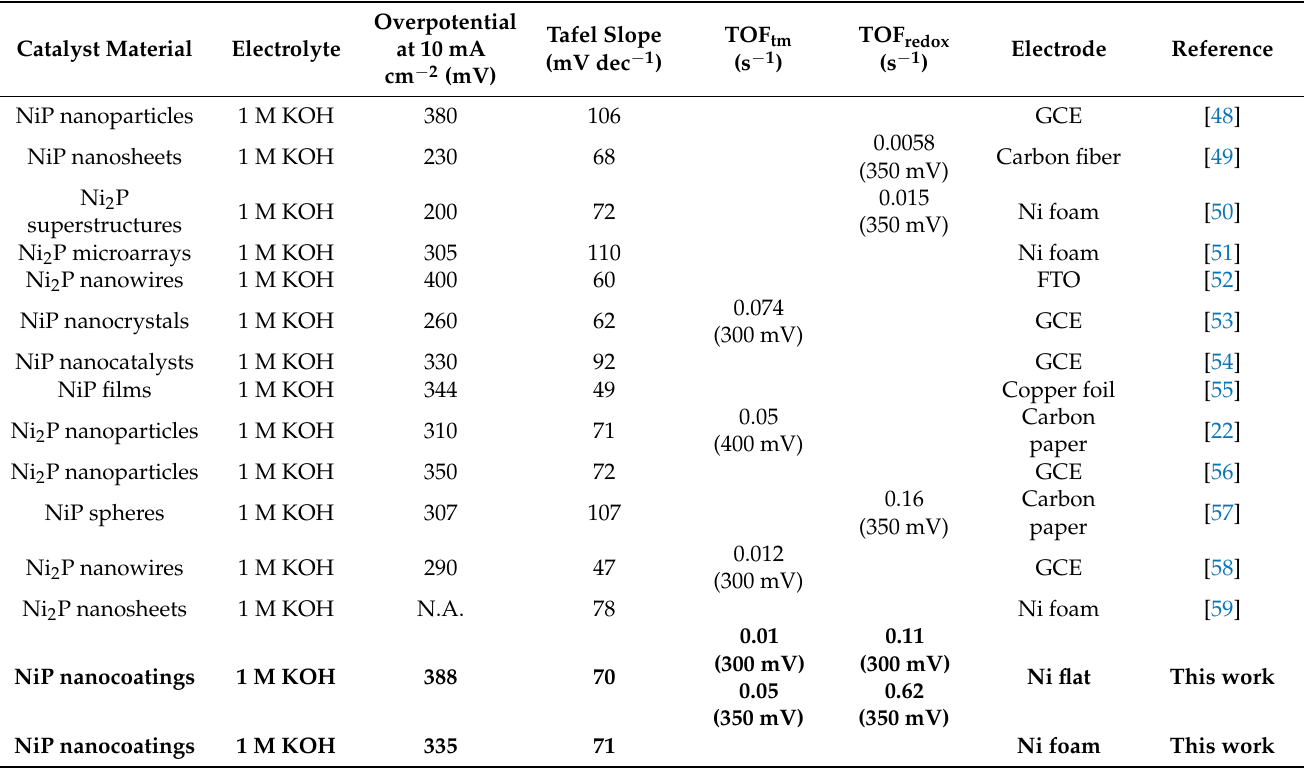
Table 2. Activity metrics of Ni–P-based electrocatalysts for the